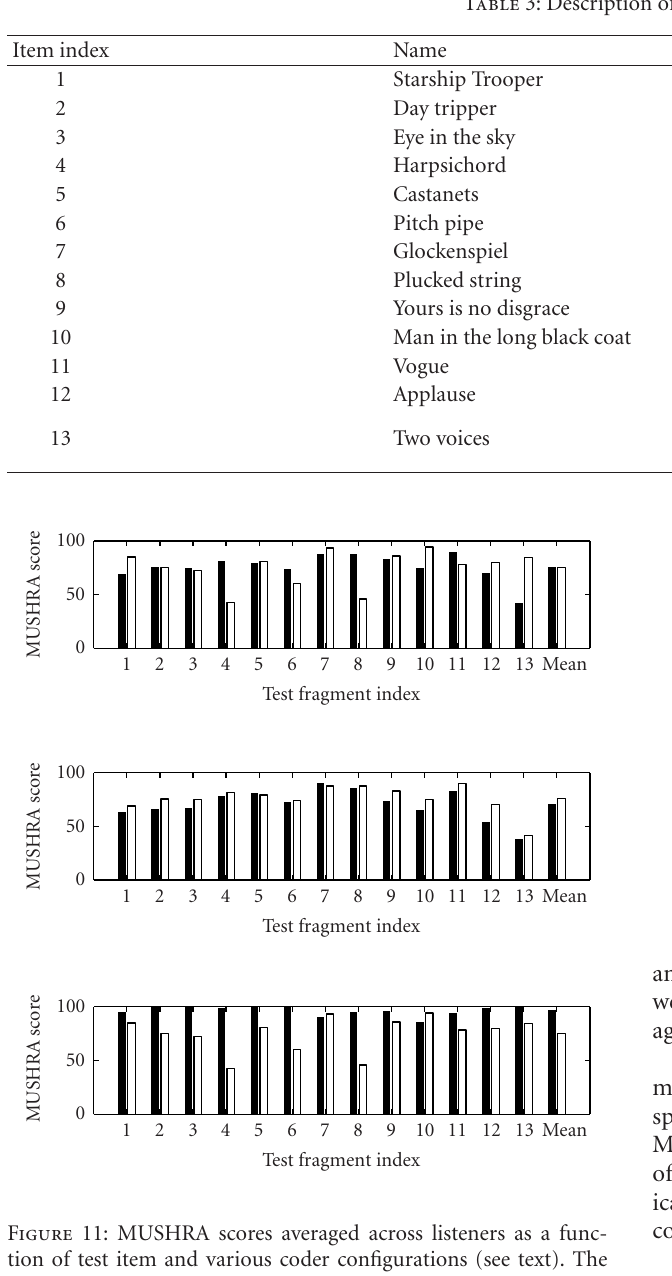
Figure 11: MUSHRA scores averaged across listeners as a func- tion of test item and various coder configurations (see text). The upper panel shows the results for 8kbps parametric stereo (black bars) against stereo MP3 at 128 kbps (white bars). The middle panel shows the results for 5 kbps parametric stereo (black bars) versus 8kbps parametric stereo (white bars). The lower panel shows the hidden reference (black bars) versus MP3 at 128 kbps (white